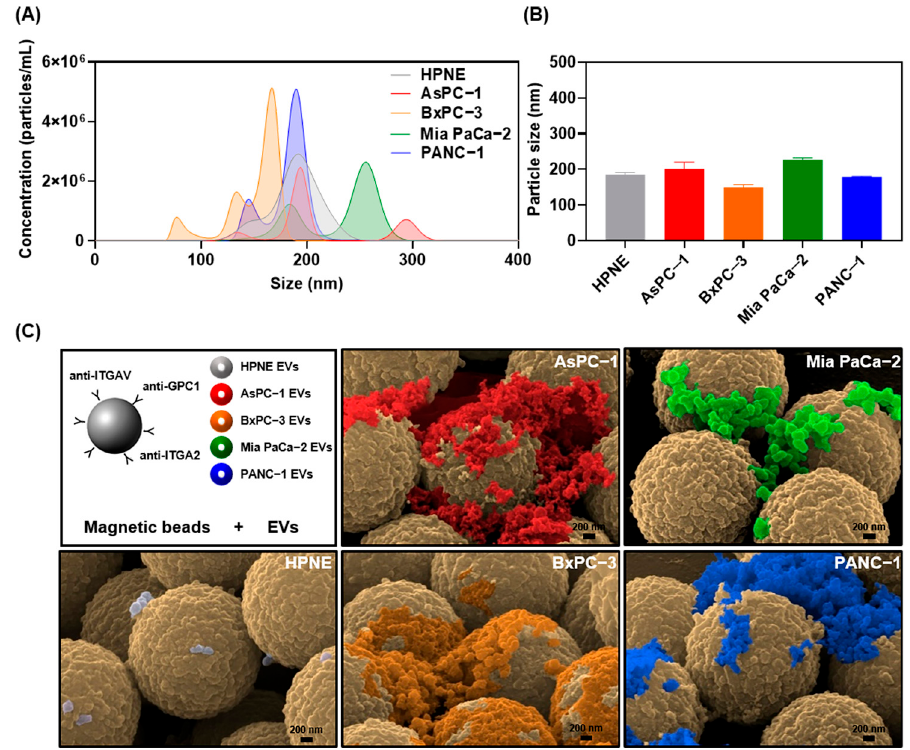
Figure 3. Enrichment of pancreatic tumor cell-derived EVs by immunoprecipitation with magnetic beads. ( A ) Particle size distribution of EVs isolated from HPNE, AsPC − 1, BxPC − 3, Mia PaCa − 2, and PANC − 1 cell lines. The area under the curve represents the absolute number of particles isolated from the concentrated culture medium. ( B ) Mean particle sizes of EVs were analyzed in triplicate and graphed. ( C ) SEM images of EVs bound to surfaces of magnetic microbeads after immunoaffinity capture. Microbeads were functionalized with antibodies against the pancreatic cancer associated surface markers ITGAV, ITGA2, and GPC1. Scale bars represent 200 nm.